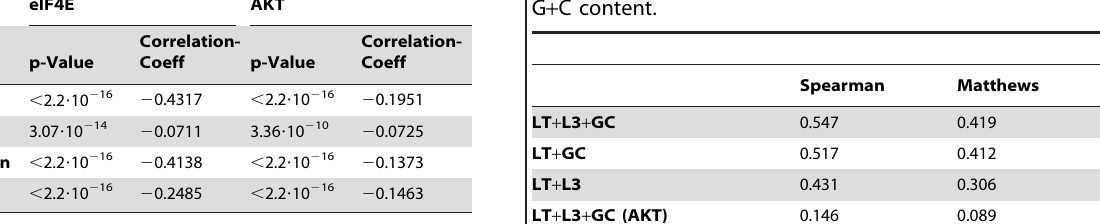
Table of correlations between length of mRNA (total mRNA, 5 9 UTR, coding, 3 9 UTR) and the eIF4E fold change for the eIF4E dataset. P-values and correlation coefficient are computed according to the Spearman correlation for the eIF4E overexpression data set (11387 mRNAs) and the AKT activation data set (7496 mRNAs).